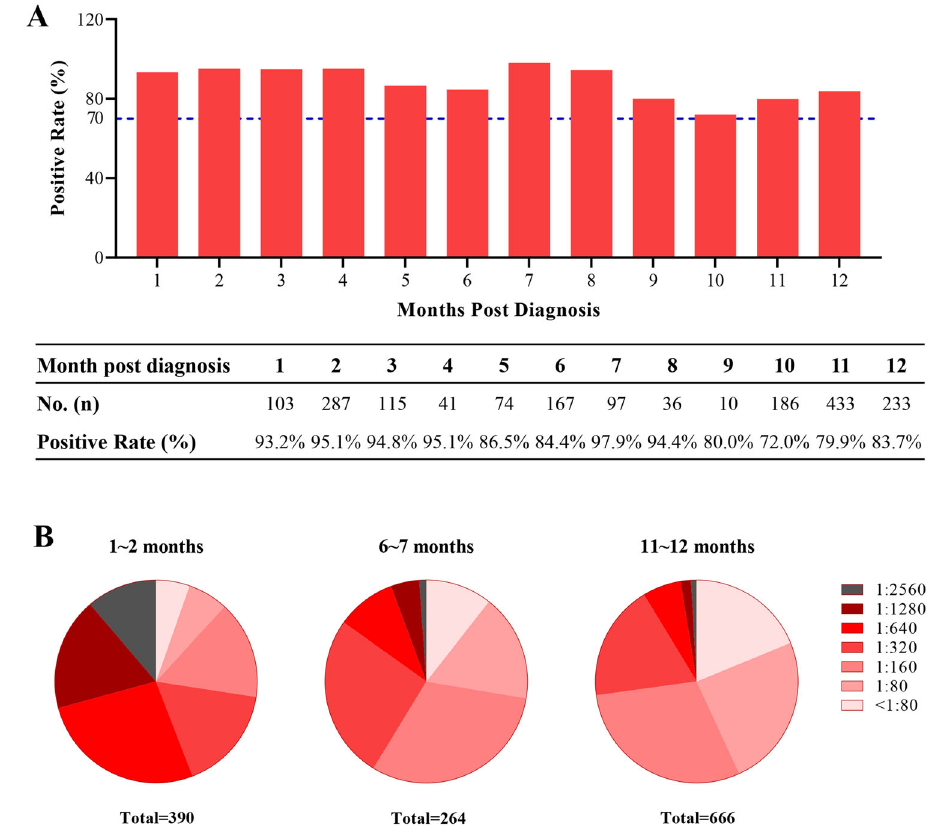
Fig. 1 RBD-IgG titers against SARS-CoV-2 over times. A Percentage changes of positive RBD-IgG. B Changes of RBD-IgG titers distribution. The titers of RBD-IgG are categorized as 1:80 (the actual value range is greater than or equal to 80 but less than 160), 1:160 (the actual value range is greater than or equal to 160 but less than 320), 1:320 (the actual value range is greater than or equal to 320 but less than 640), 1:640 (the actual value range is greater than or equal to 640 but less than 1280), 1:1280 (the actual value range is greater than or equal to 1280 but less than 2560) and 1:2560 (the actual value range is greater than or equal to 2560). Titers less than 1:80 are considered as